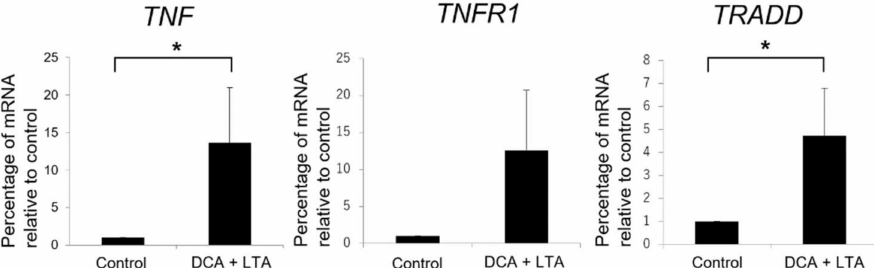
Figure 4. Effects of deoxycholic acid (DCA) and lipoteichoic acid (LTA) on tumor necrosis factor ( TNF ), TNF receptor superfamily member 1 ( TNFR1 ), and TNFR1-associated via death domain ( TRADD ) messenger RNA (mRNA) expression levels in LX-2 cells. The mRNA expression levels were normalized to those of β -actin and are presented as mean percentages relative to control ± standard deviation. The p -values were as follows: TNF , 0.036; TNFR1 , 0.053; and TRADD , 0.048. TNF and TRADD mRNA expression levels were significantly higher in the DCA (300 µ M) + LTA (25 µ g/mL) group than in the control